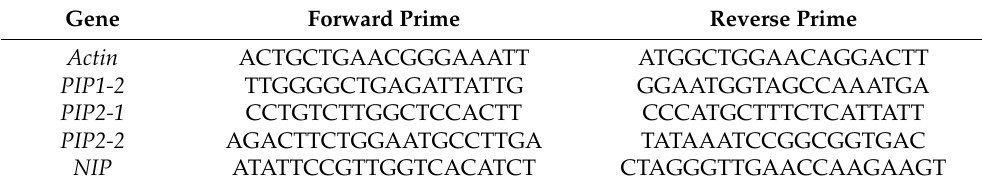
Table 1. Gene-specific primers sequence for qRT-PCR